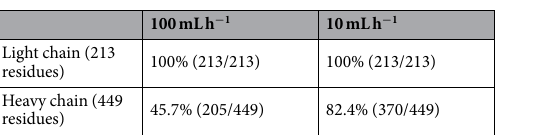
Table 2. Identified amino acids from a recombinant human IgG1 antibody using the Pep-SpM. The ratio of the detected amino acids was estimated from the all the results of peptides mapping by PepFinder 2.0.